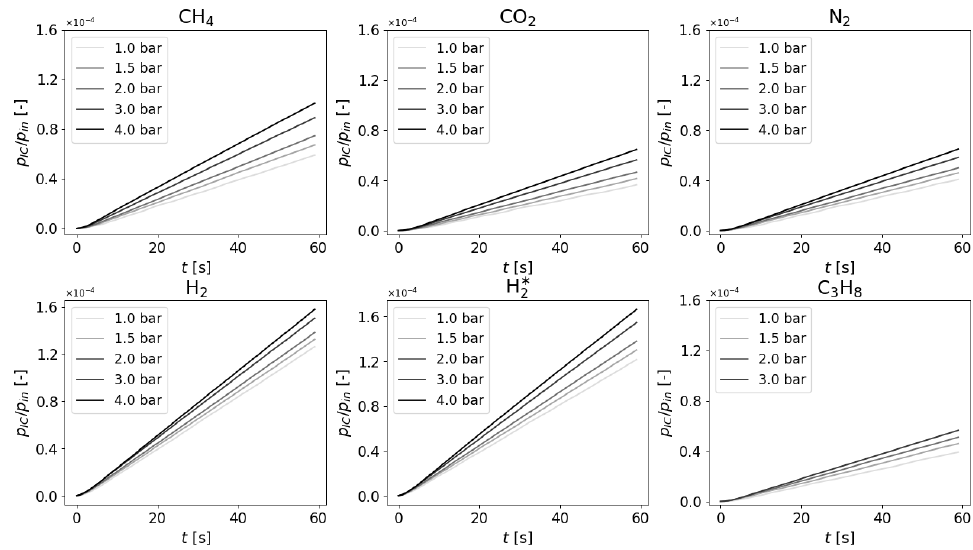
Figure 2. Measurements of increasing pressure detected in the integral cell of manometric integral permeameter, normalized by input pressure. Without the nonlinearity, measurements would be expected to align.